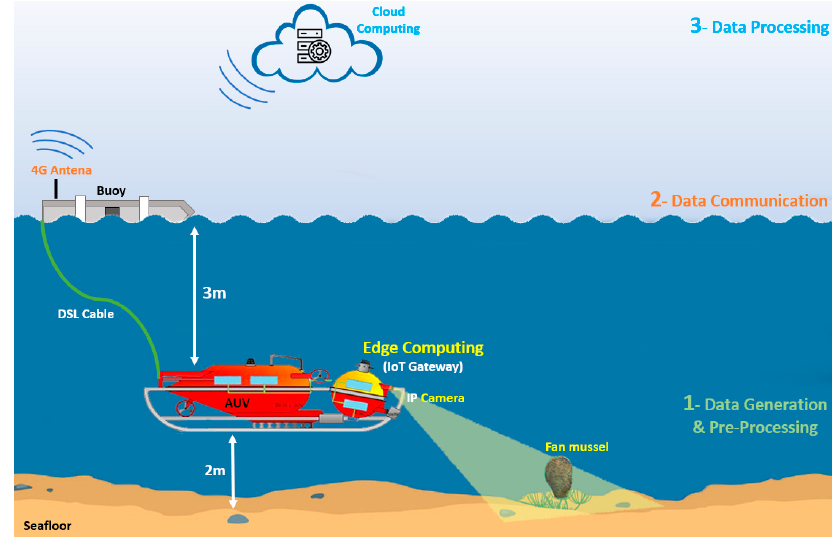
Figure 1. Proposed AUV-IoT Platform.